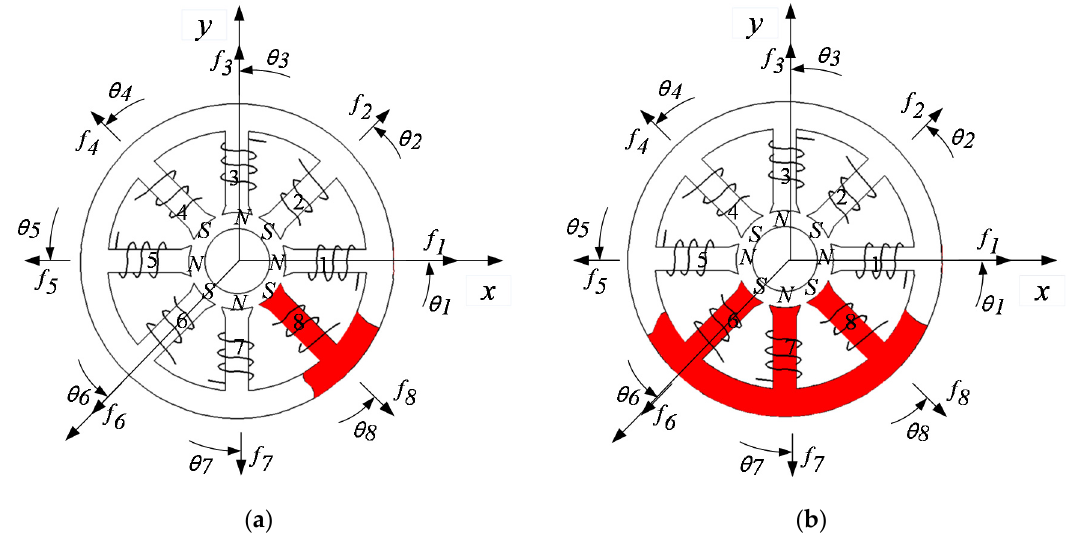
Figure 7. The 8th pole coil and 6-7-8th coils fail in magnetic bearing, marking red in ( a ) and ( b ), respectively.